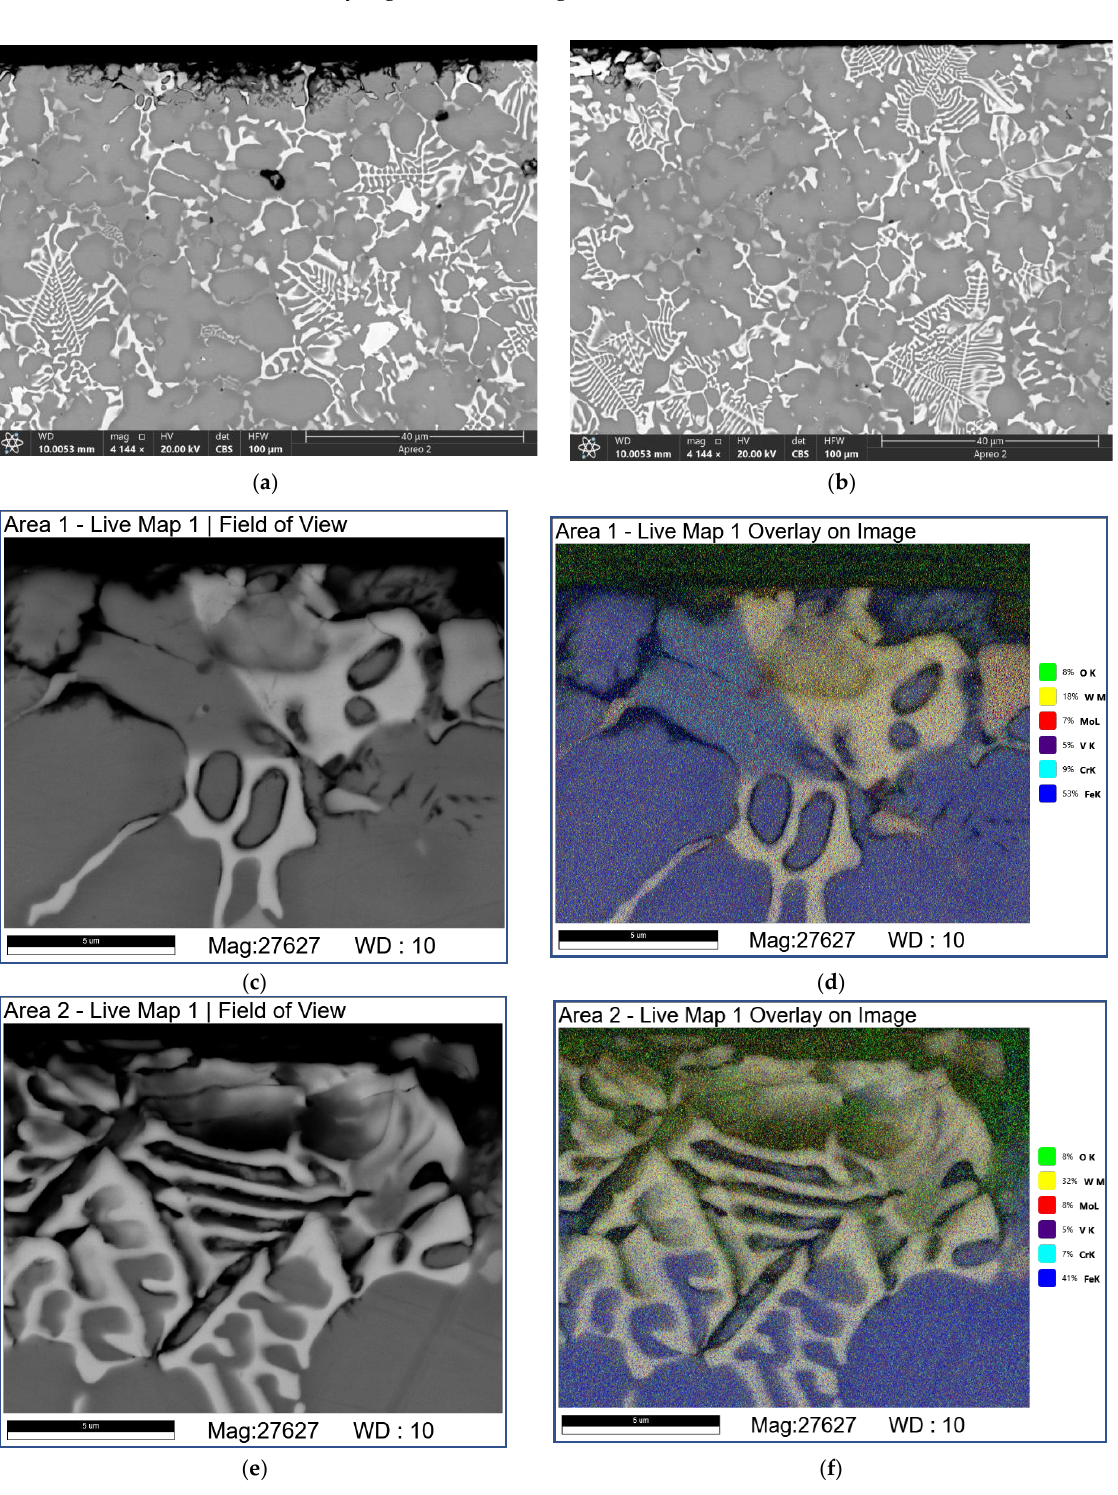
Figure 14. The SEM BSE images ( a – c , e ) and overlay EDS images ( d , f ) of the M2/W coating subsurface microstructures. Data presented for specimens after sliding at 0.8 m/s. The subsurface structures obtained after testing at a sliding speed of 2.4 m/s reveal the carbide fragments aligned along the matrix plastic flow direction in accordance with the friction force action (Figure 15a,b,e). The plastic deformation penetration is about 20 μm. The thickness of MML is about 1 μm (Figure 15c,d).